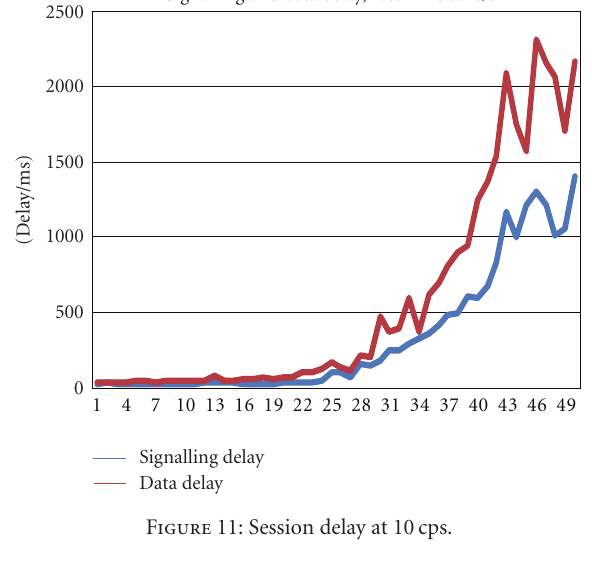
Figure 11: Session delay at